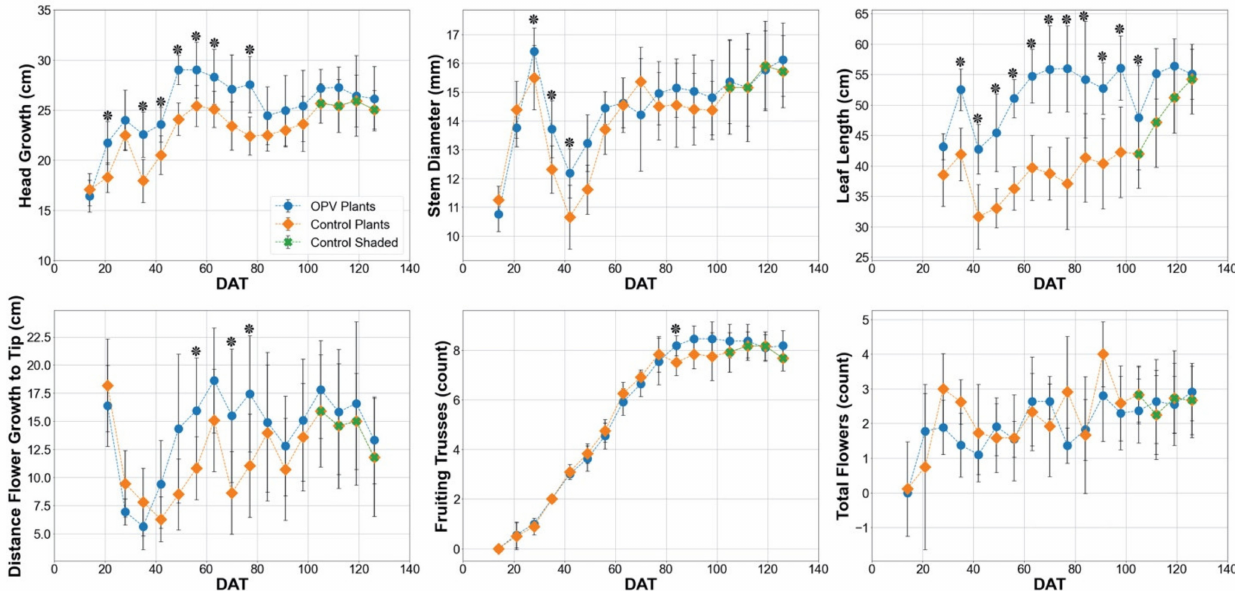
Figure 9. Weekly plant growth in the OPV and Control sections; parameters measured include head growth, head diameter, leaf length, distance of first open flower to plant tip, number of fruiting trusses, and the total number of flowers; days after transplant (DAT); each data point represents the averaged values of 6 sample plants, with bars representing the standard deviation; the indicates a significant difference based on a two-sample t -test statistic, calculated for the OPV and Control